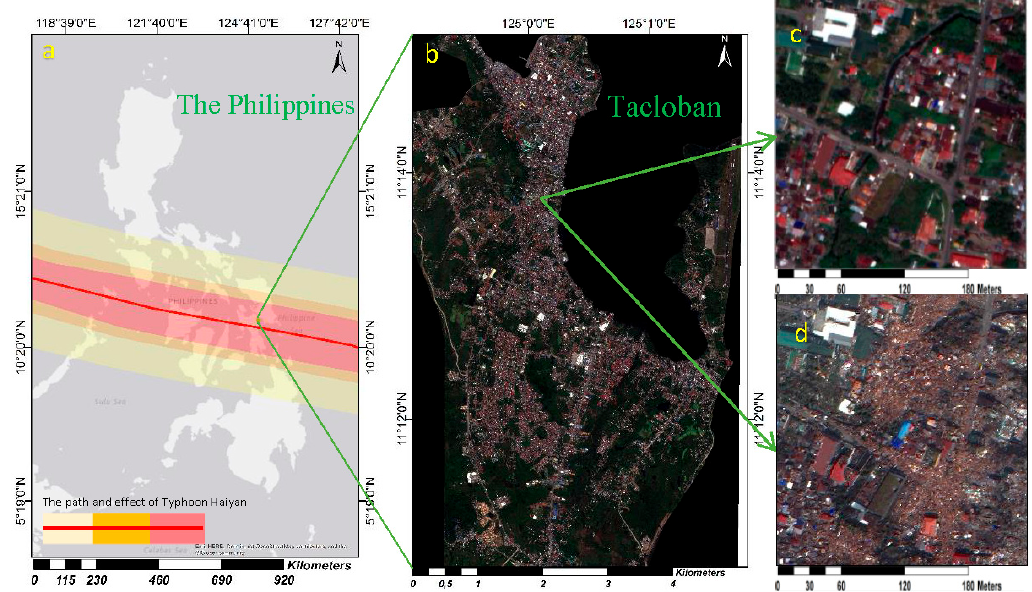
Figure 5. An overview of the Philippines showing the path of Typhoon Haiyan ( a ) and the location of Tacloban city ( b ). Pre-disaster image ( c ) and an image acquired three days after the disaster ( d ). The WorldView2 (WV2) pan-sharpened images with 0.5 m spatial resolution and four multispectral bands (Blue, Green, Red, NIR) acquired 8 months before, 3 days after, and 4 years after